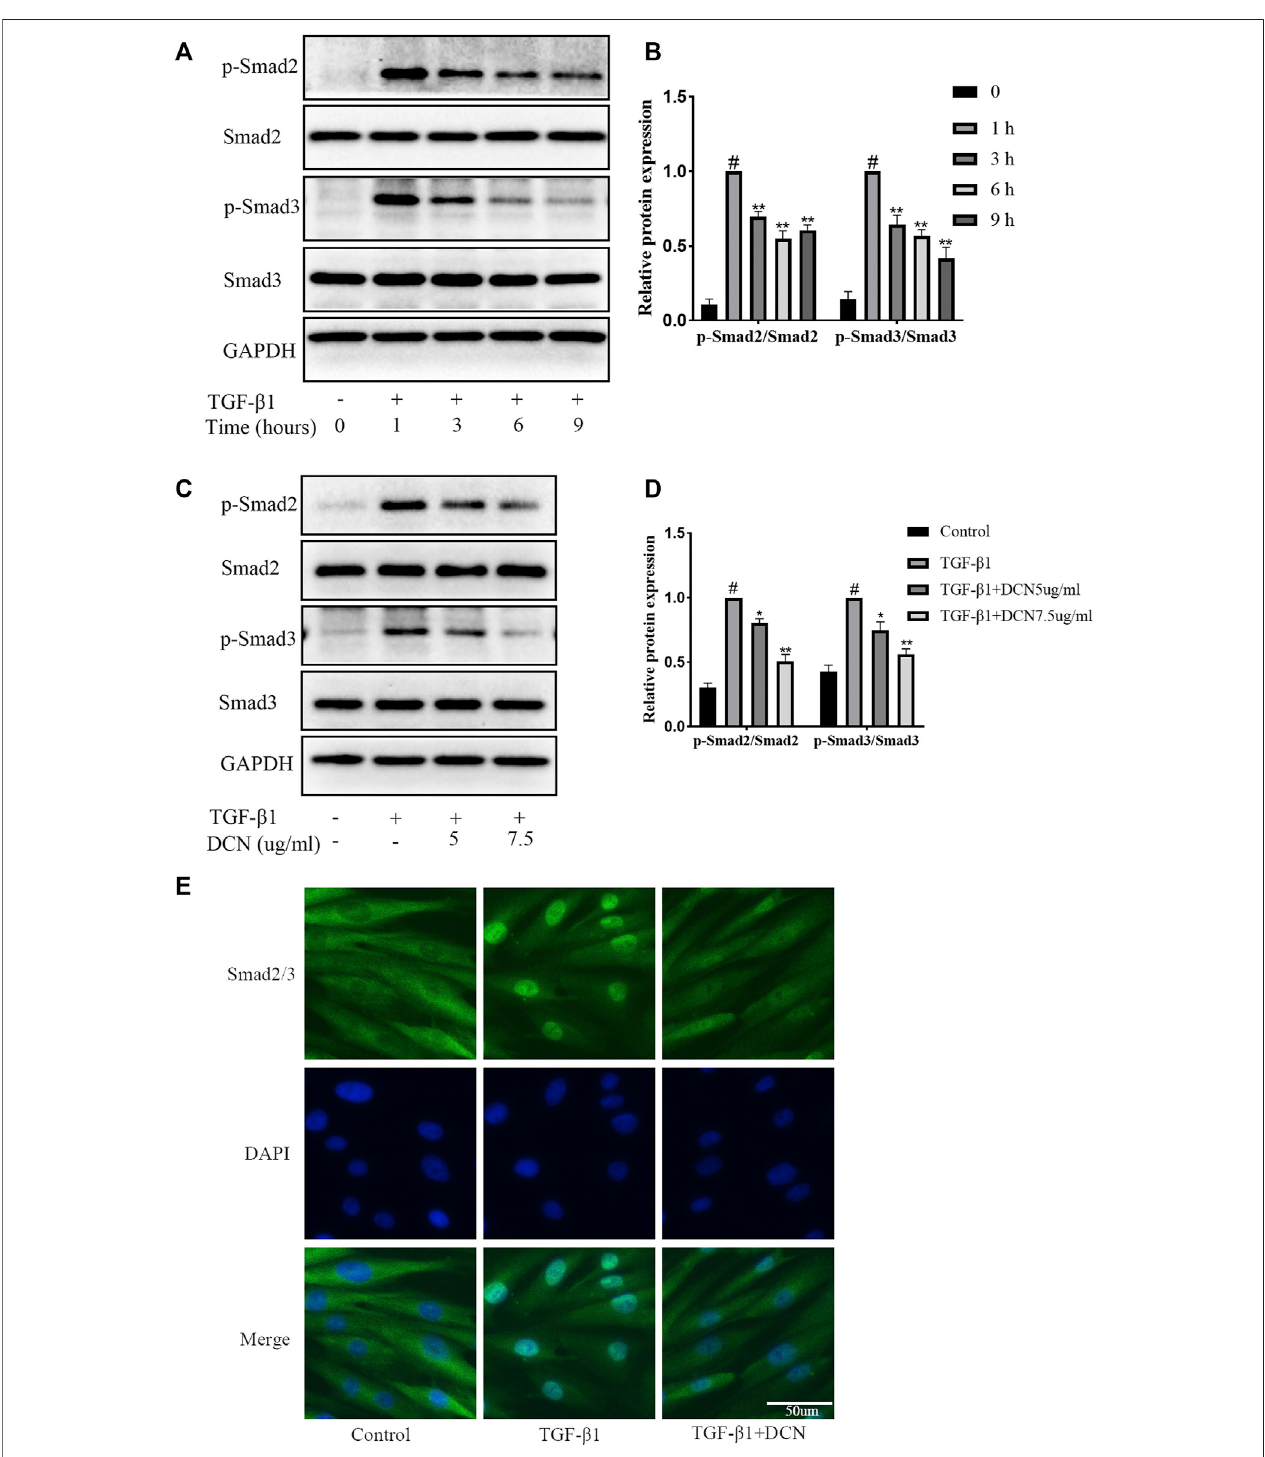
FIGURE 4 | Decorin (DCN) inhibits TGF- β 1-induced Smad2/3 signaling pathway activation. (A) Western blotting and (B) quanti fi cation analysis of Smad2, p-Smad2, Smad3, and p-Smad3 from TGF- β 1-treated fi broblasts at different time points (0, 1, 3, 6, and 9 h). (C) Western blotting and (D) quanti fi cation analysis of Smad2, p-Smad2, Smad3, and p-Smad3 from fi broblasts after treated with DCN (5 and 7.5 µg/ml) for 2 h, followed by incubation with TGF- β 1 (5 ng/ml) for 1 h. (E) Nuclear translocation of Smad2/3 was detected by immuno fl uorescence. # p < 0.05 vs control group; * p < 0.05 vs TGF- β 1 group; ** p < 0.01 vs TGF- β 1 group.